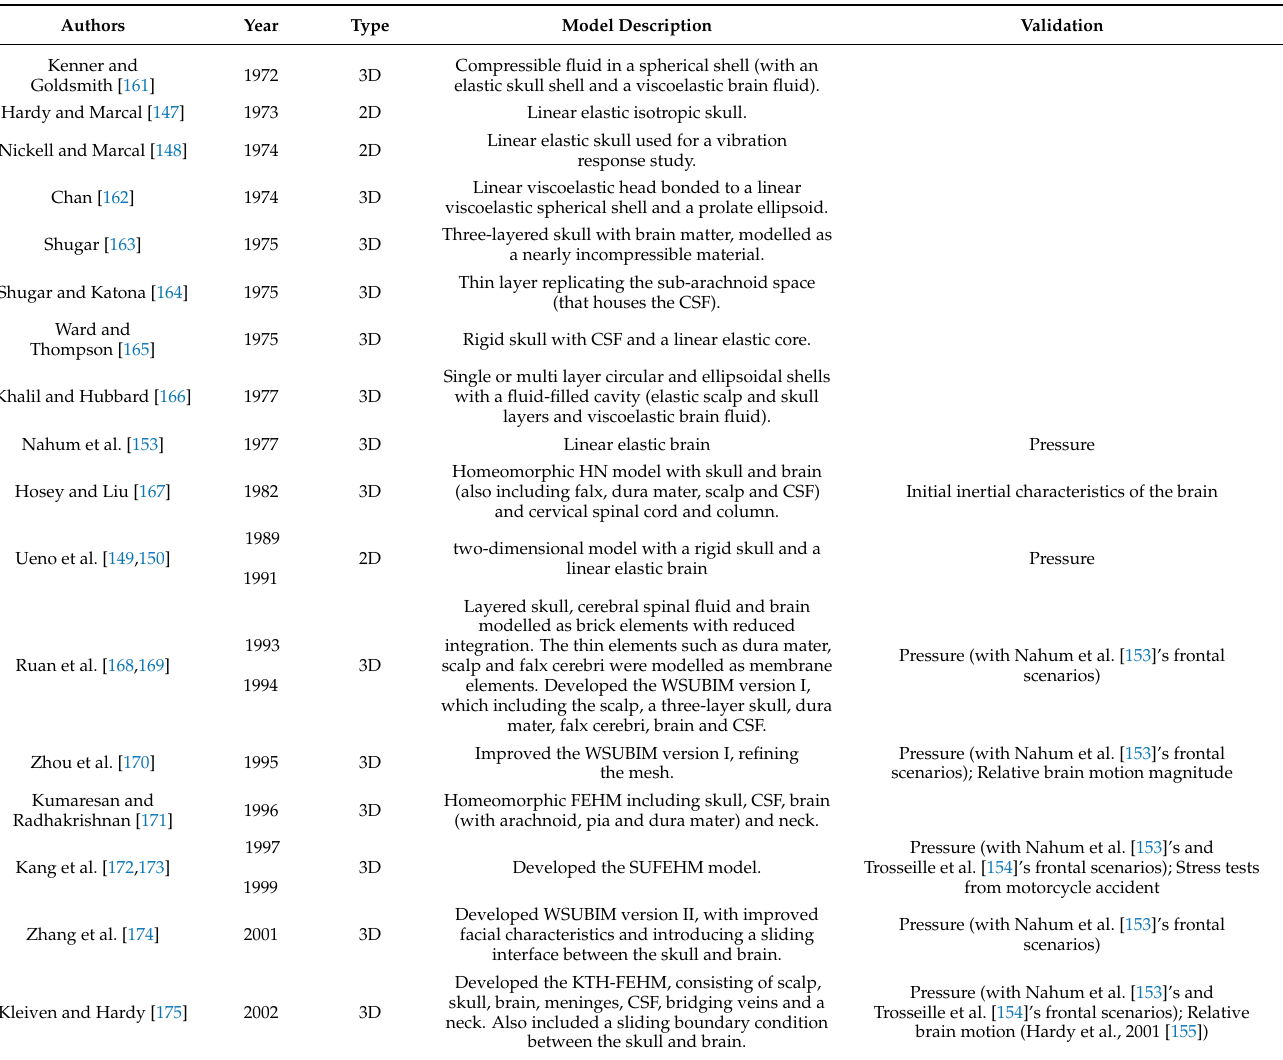
Table 1. Literature review on prominent Finite Element head